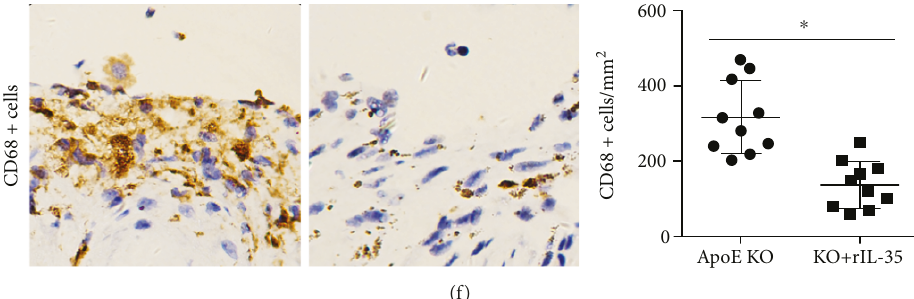
Figure 5: rIL-35 ameliorates the development of atherosclerosis. The atherosclerotic plaque area of (a) aortic trees (10x) and (b) aortic roots (10x) in these two groups was detected by oil red O staining. The aortic roots of (c) α -SMA-positive area (20x), (d) collagen-positive area (20x), (e) CD4+ T lymphocyte (40x), and (f) macrophages (40x) were measured in the two groups. ApoE KO=ApoE-/-, DKO=ApoE-/- IL-12p35-/-; N = 10 for each group. ∗ P < 0 05 vs. the ApoE-/-